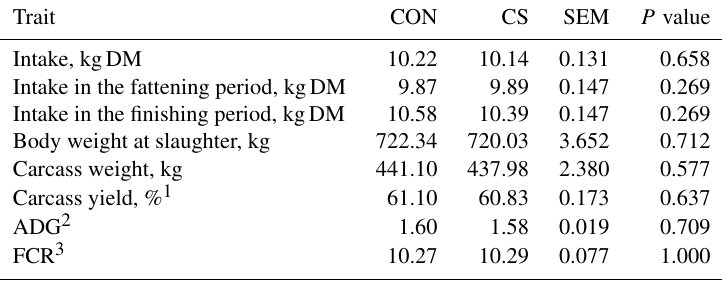
Table 3. Average individual feed intake and growth performance traits (least-square mean and standard error of the mean – SEM) of control (CON) and commercial supplement (CS) groups.